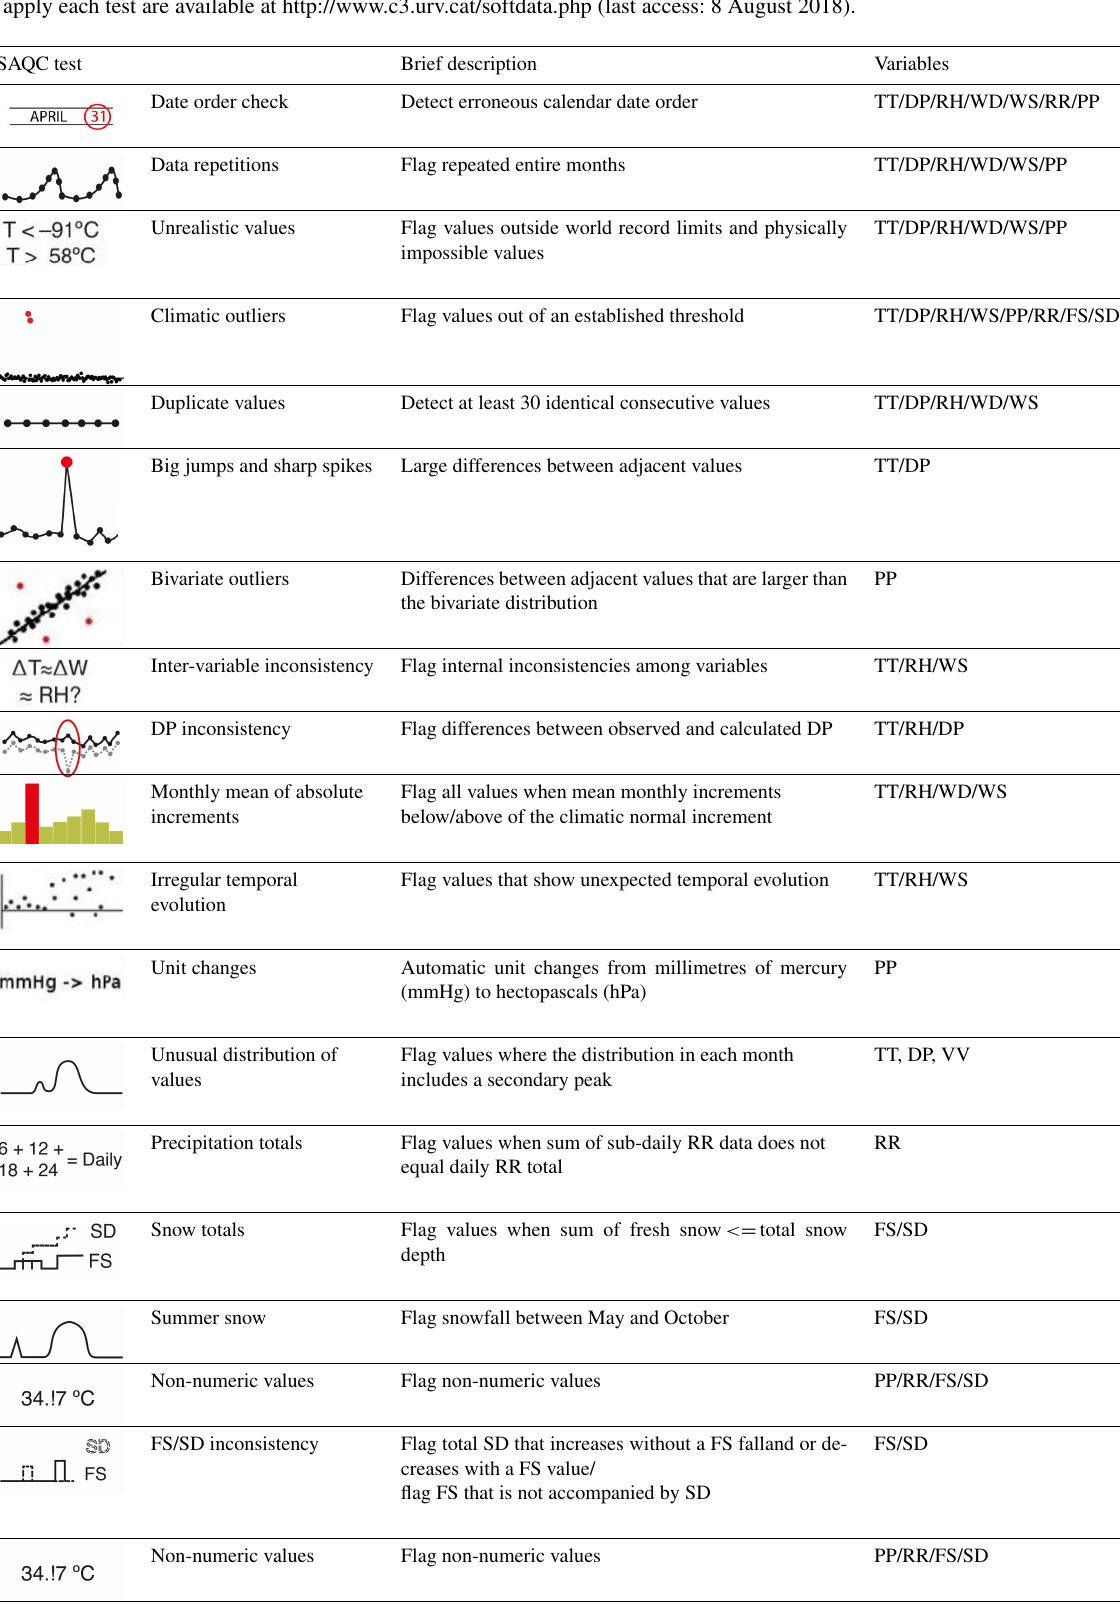
Table 3. Descriptions of the SAQC tests applied for each climate variable. Variable acronyms are as those described in Table 1. The programs used to apply each test are available at http://www.c3.urv.cat/softdata.php (last access: 8 August